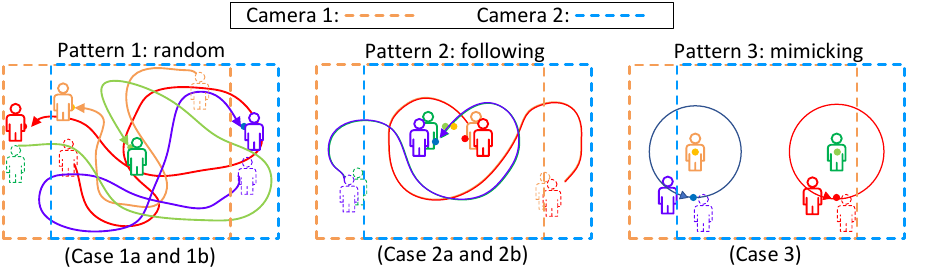
Figure 9. Mobility patterns for